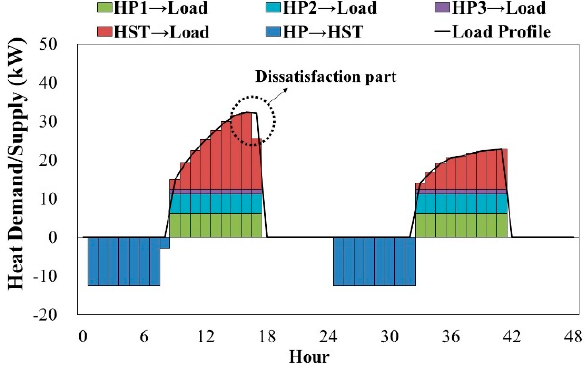
Figure 14. Operation check.